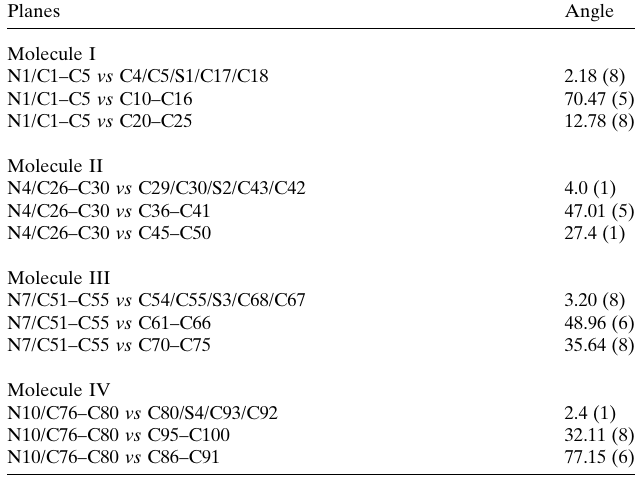
Table 1 Selected torsion angles ( (cid:4) ).